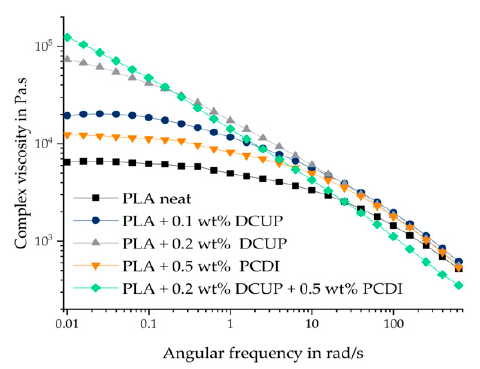
Figure 3. Rheological measurements of the PLA compounds.